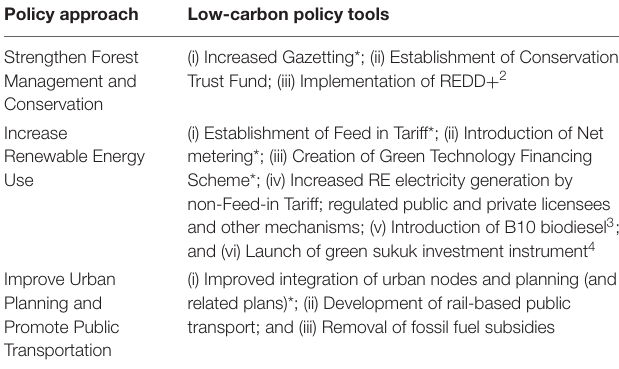
TABLE 2 | Malaysia’s low-carbon policy toolkit 1